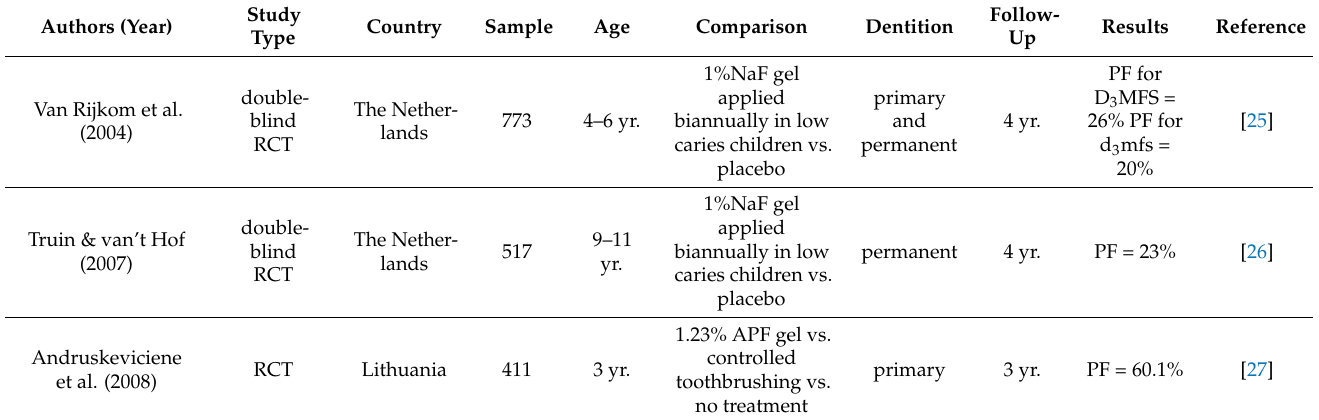
Table 1. Comparative data about professionally applied fluoride